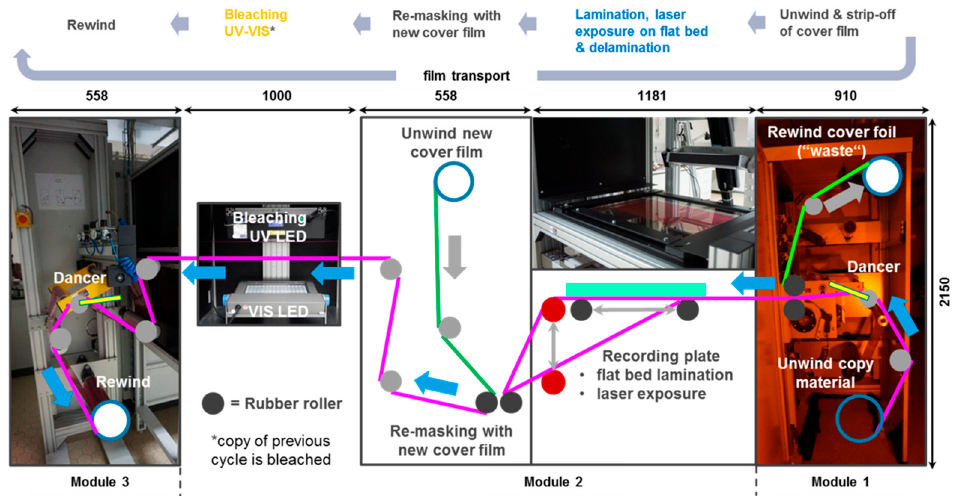
Figure 24. Film handling diagram of the R2R machine with dimensions in millimeters and process description [55].